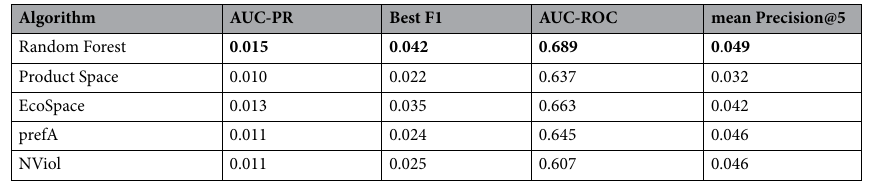
Table 3. Comparison between our Random Forest model and other approaches proposed in literature. The Random Forest provides a better assessment of the relatedness with all the performance indicators. The highest values of each indicator are in